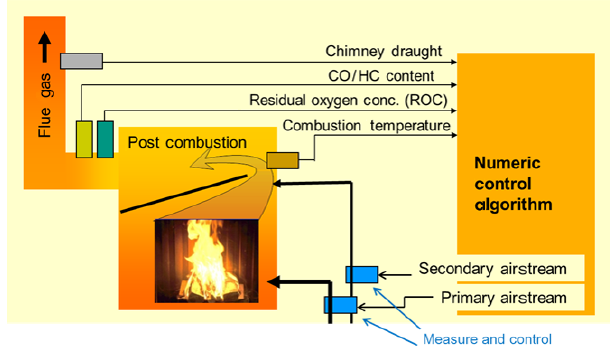
Figure 1. A schematic representation of an automated airstream- controlled wood combustion